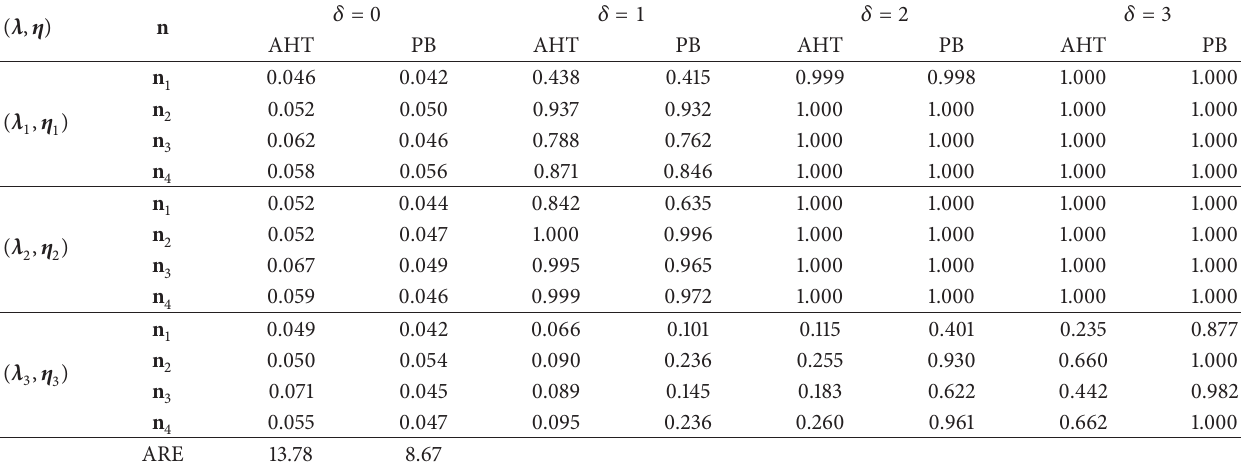
Table 3: Empirical sizes and powers of the two tests for nested effects for 10-variate two-factor multivariate nested designs [ 𝑎 = 3, 𝑏 1 = 3, 𝑏 2 = = 7 , ( Σ , Σ ,..., Σ ) = 1 𝑇 ⊗ ( I , diag ( 𝜆 ), diag ( 𝜂 )) ]. 5, 𝑏 3 11 12 𝑎𝑏 𝑎 3 10 ( 𝜆 , 𝜂 )